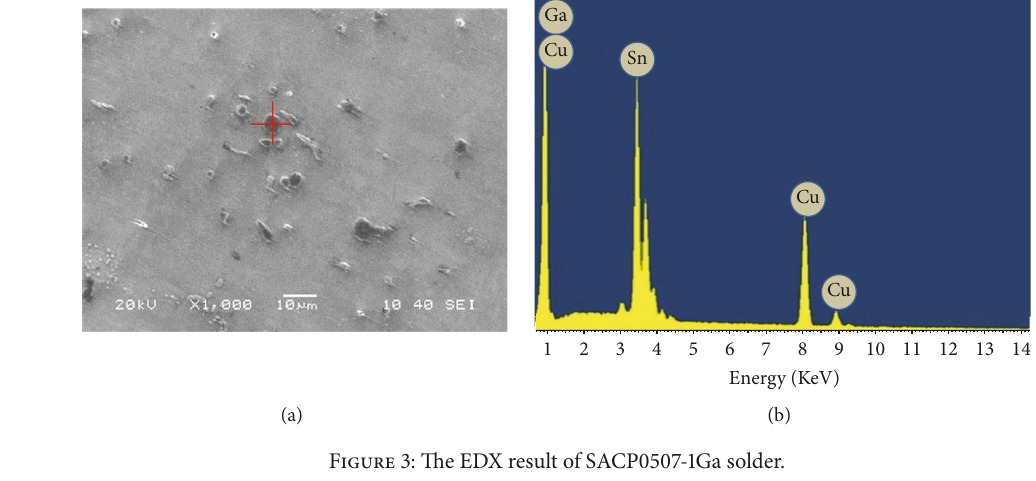
Figure 3: The EDX result of SACP0507-1Ga solder.